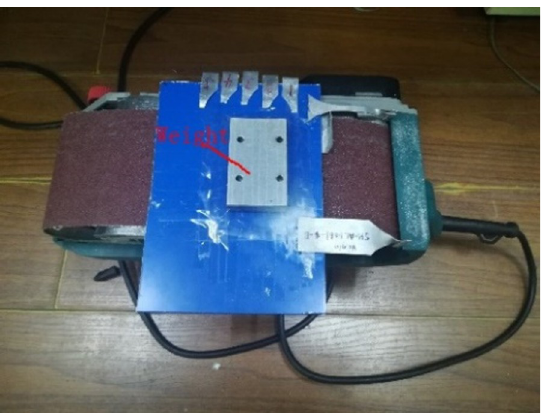
Fig 5. Grinding of